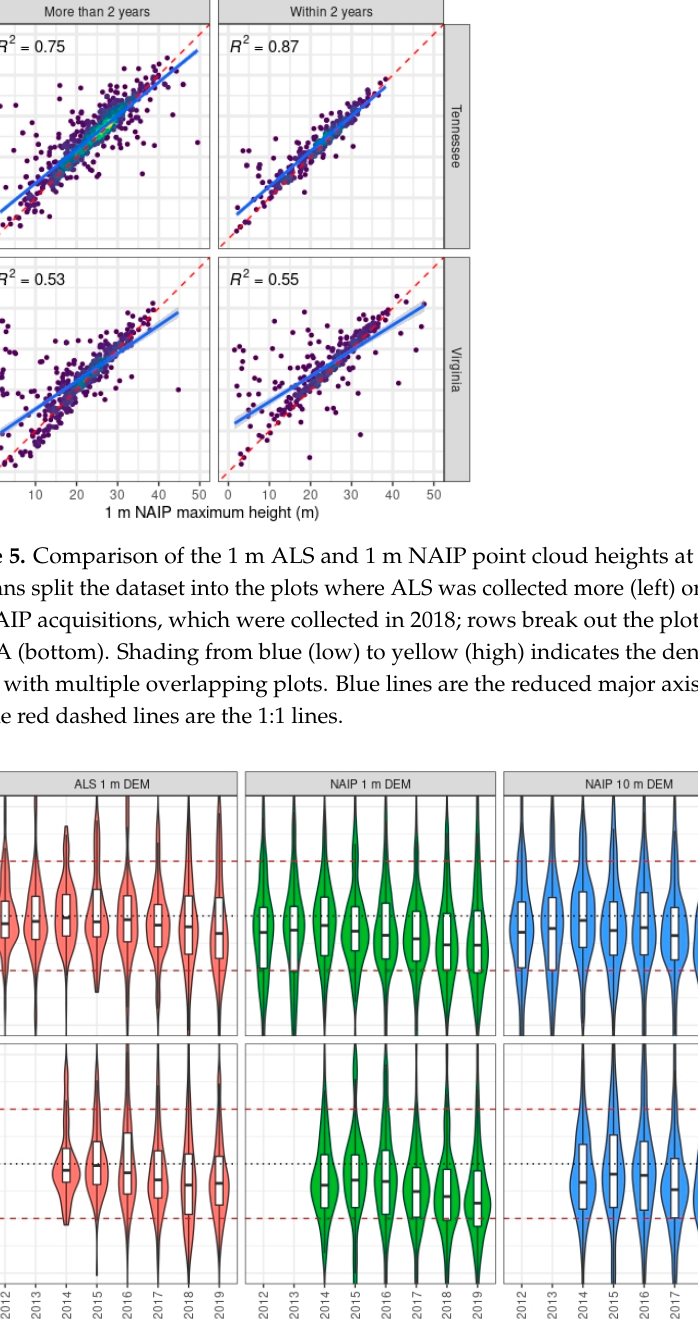
Figure 7. Comparison between 1 m NAIP natural color composite (left), 10 m NAIP DHM (center), and 2 m NAIP DHM (right) for softwood ( A ) and hardwood ( B ) areas in the state of TN.